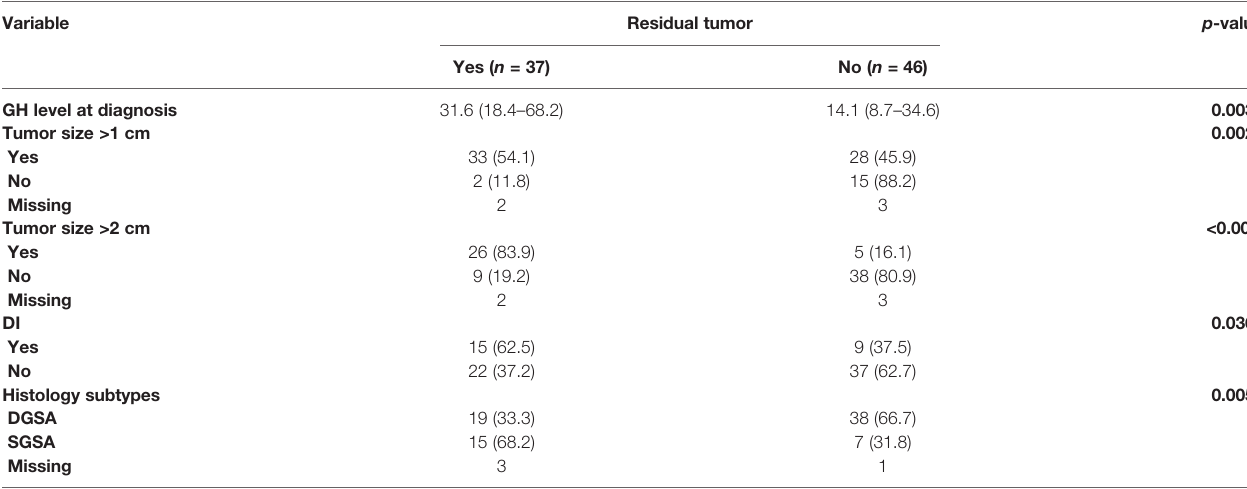
TABLE 4 | Association of residual tumor and other